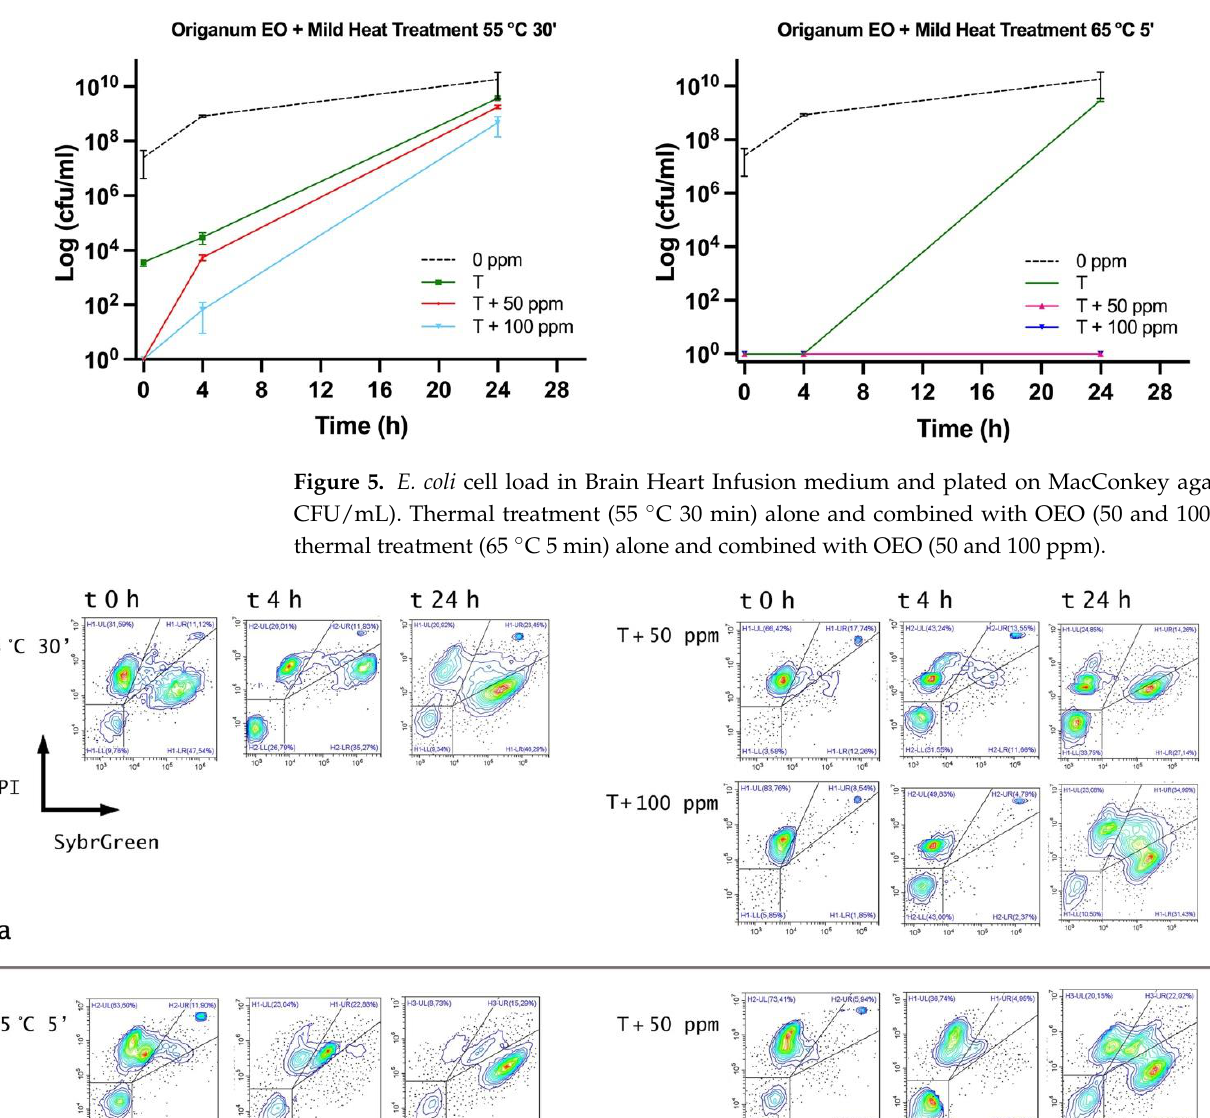
9 of 20 Figure 4. Percentage of alive, dead, and damaged cells calculated on total FCM events (100%): 50 ppm and 100 ppm OEO treatment at 0, 4, and 24 h compared to 0 ppm. The shown values corre- spond to the means and standard deviations for replicates, independently analysed. p -value less than 0.001 is flagged with three stars (***). 3.3. Effect of Antimicrobial Treatment in Synthetic Medium and Recovery Ability: Mild Heat- OEO